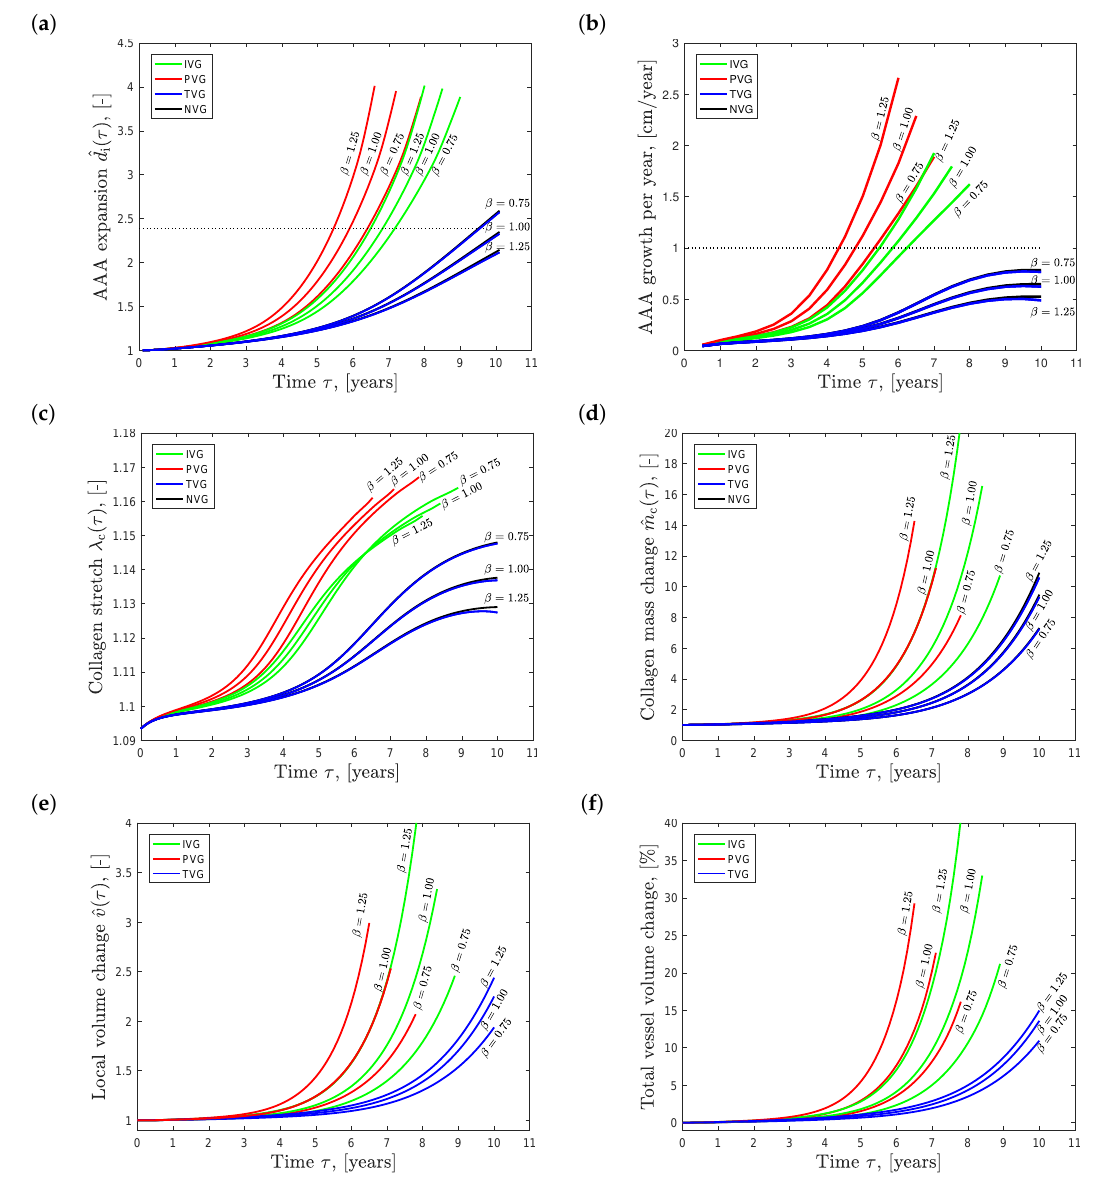
Figure 5. Effect of collagen net growth (parameter β ) on the predicted Abdominal Aortic Aneurysm (AAA) expansion over time τ . Isotropic Volume Growth (IVG), in-Plane Volume Growth (PVG), in-Thickness Volume Growth (TVG) and No Volume Growth (NVG) describe growth kinematics. ( a ) AAA expansion ˆ d i = d i / d 0 ; ( b ) AAA growth per year; ( c ) collagen stretch λ c ; ( d ) collagen mass change ˆ m c ; and ( e ) local tissue volume change ˆ v at the site of the maximum diameter d i ; ( f ) Total tissue volume change over time. Clinically used AAA repair indication of 55.0 (mm) and 10.0 (mm/year) is shown by the dotted line in ( a ) and ( b ),